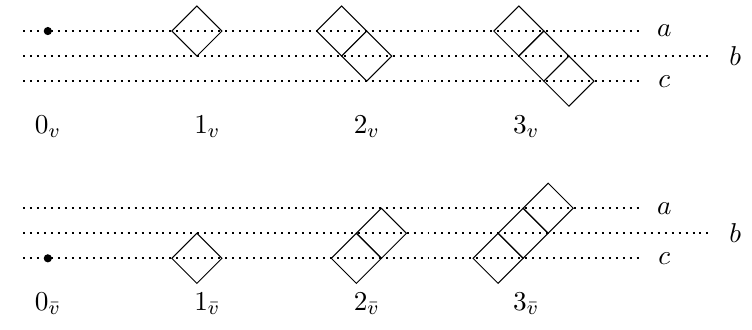
Figure 5 . The list of diagrams for the cases with fermions and antifermions only. The indices v and ¯ v indicate weather a diagram starts from the spaces a or c respectively. As before three dotted lines correspond to the spaces a , b , c